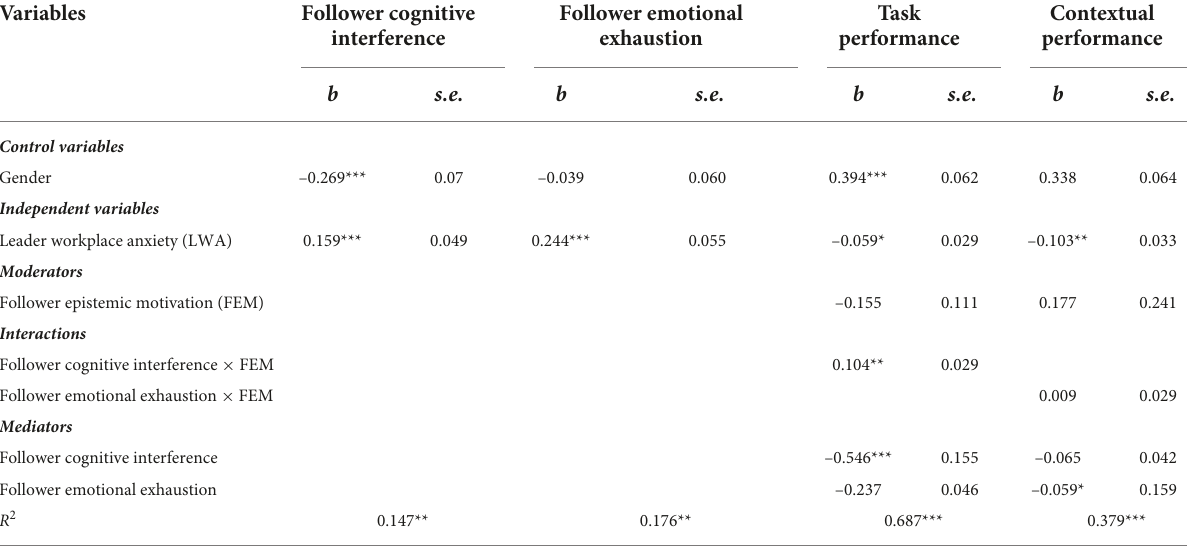
TABLE 2 Results of hierarchical regression analyses pertaining to hypotheses 1 and 2.